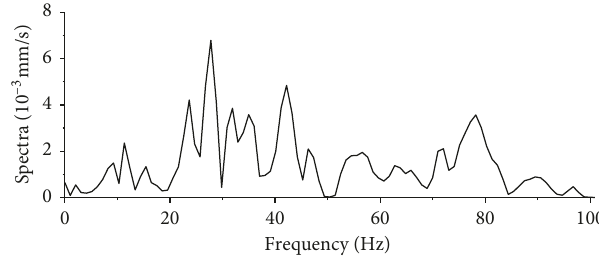
Figure 13: Autospectra of a recorded signal (no. 1).